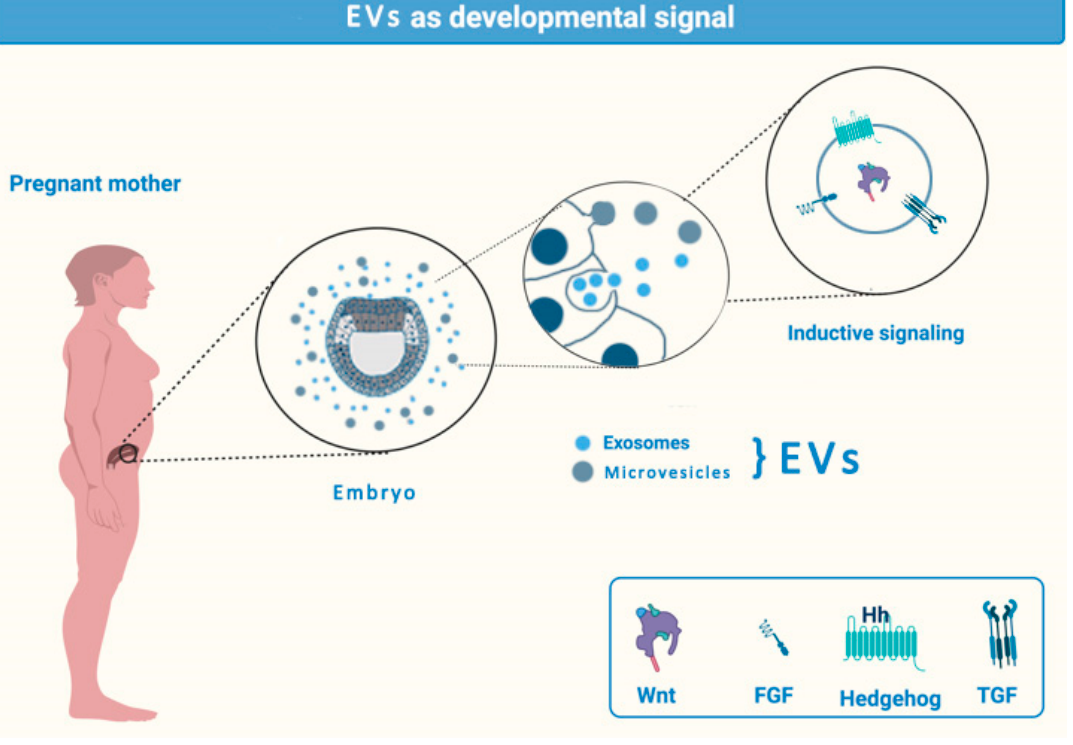
Figure 1. Exosomes as developmental signals.